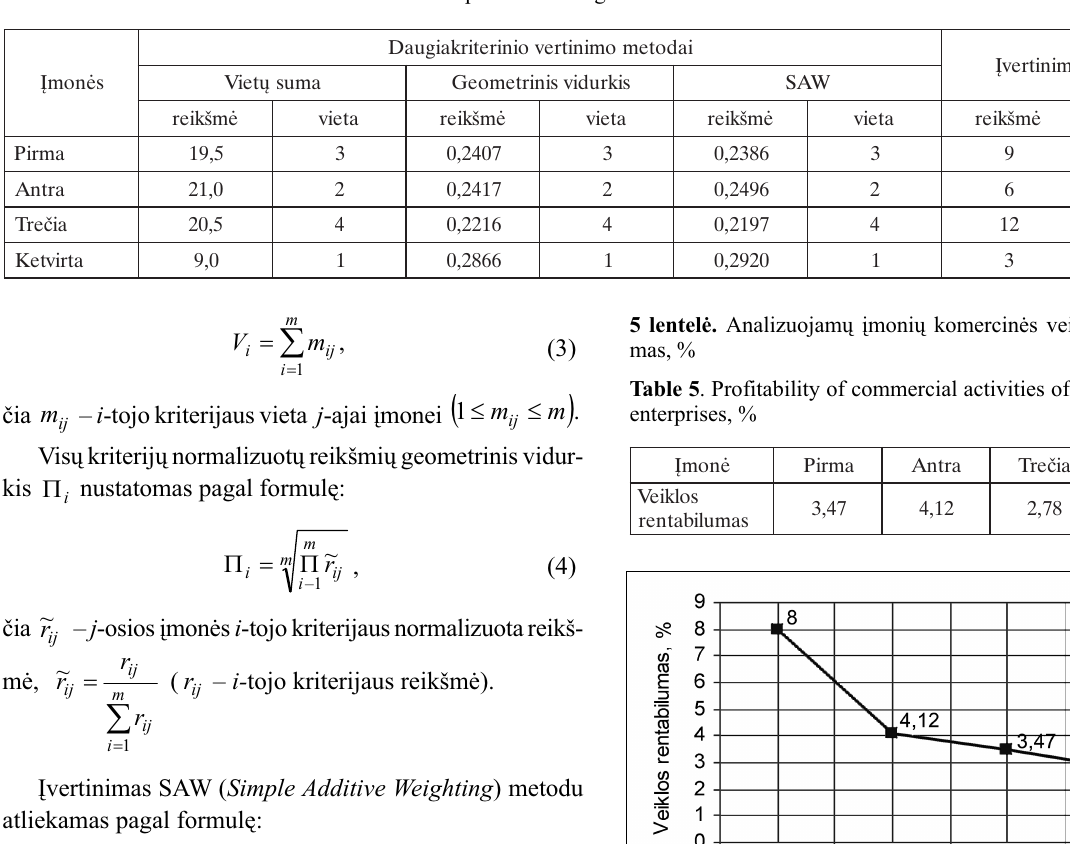
Table 4. Results of multicriteria evaluation of enterprise marketing effectiveness